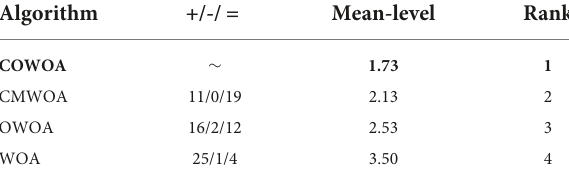
TABLE 5 Results of Wilcoxon signed-rank test.